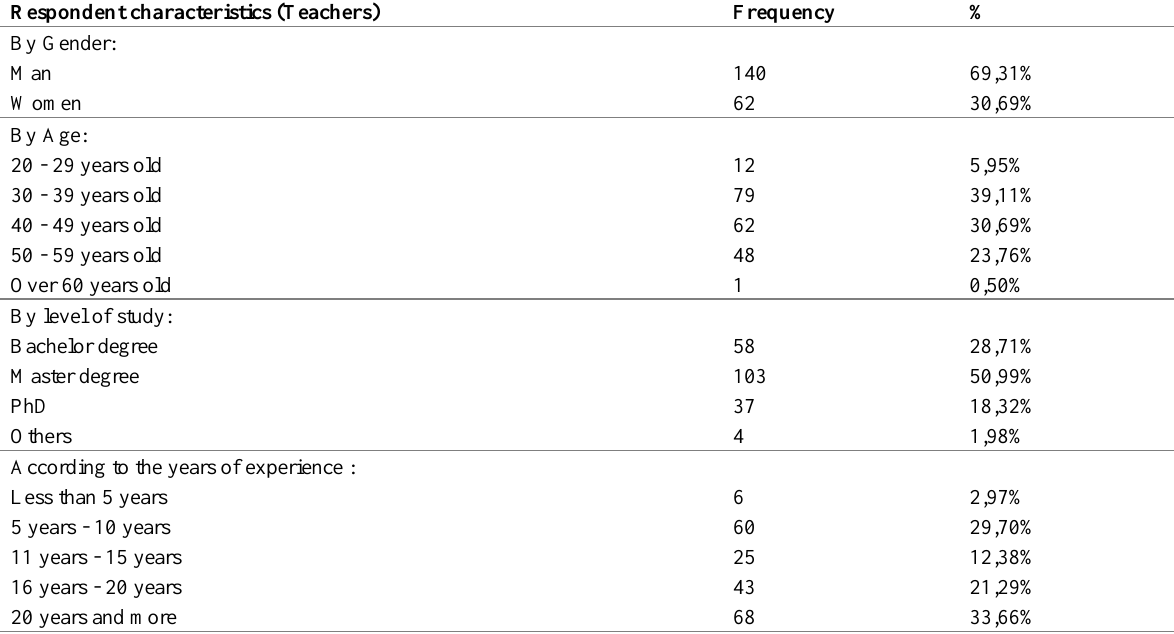
Table 2: Respondent characteristics